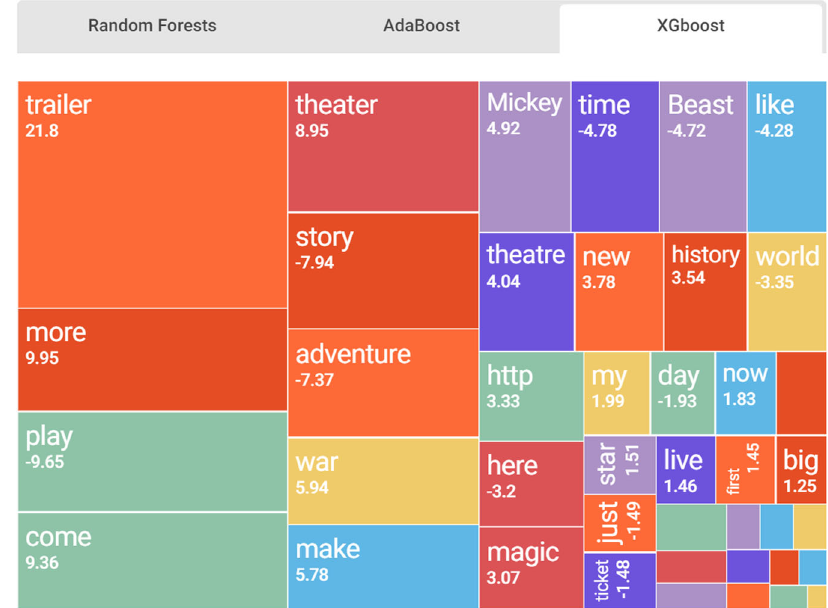
Fig. 5 Disney cues high weighting of XGboost, in the form of likes are Disney, new, http, theatre, and now as per the XGboost.